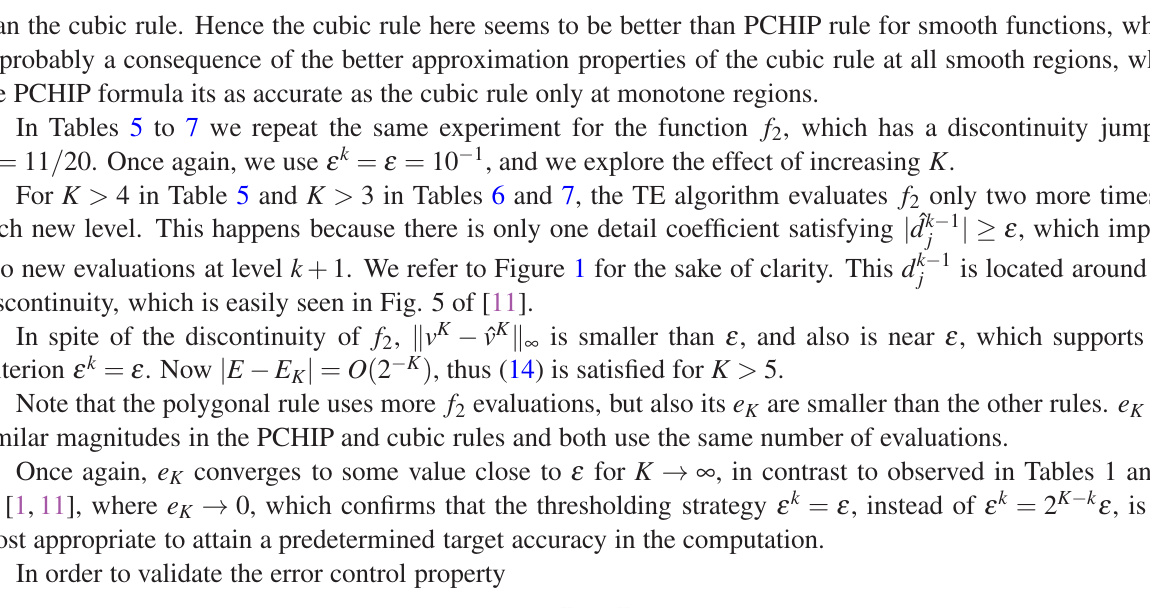
Table 6 Parameters as specified in Table 1 for f 2 , ε = ε k = 10 − 1 and the cubic rule.